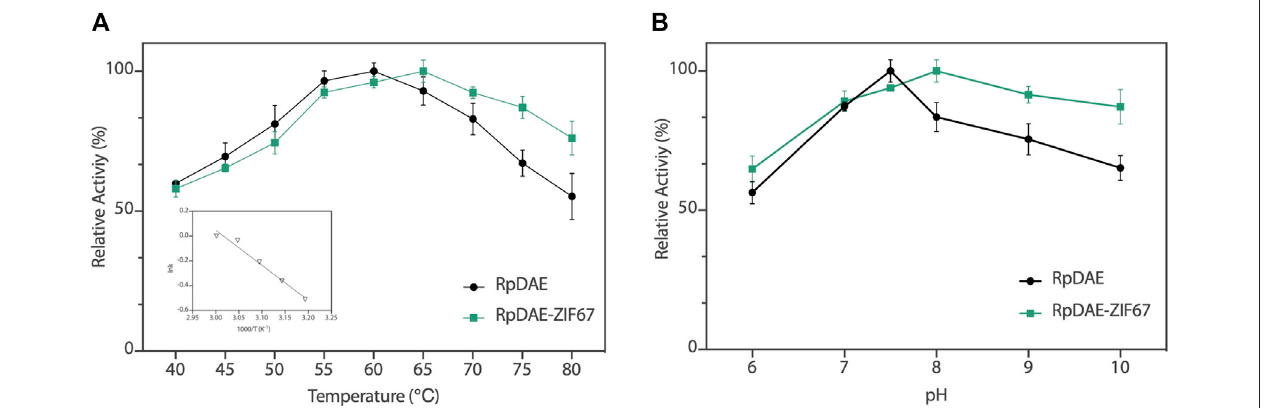
FIGURE 6 | (A) Scheme of synthesis of RpDAE-ZIF67 bio-composites. (B) PXRD patterns of RpDAE-ZIF67 and ZIF67. (C) FT-IR spectra of RpDAE-ZIF67 and ZIF67. (D) Cycle stability of RpDAE-ZIF67.